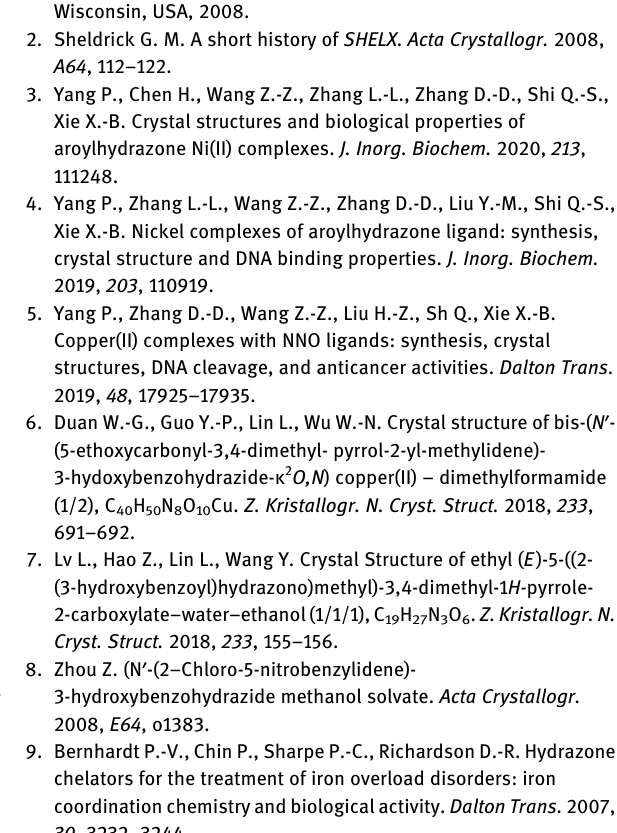
typical C=N doublebond. The C8=N2 – N1 angle is 117.15(13) ° . The two aromatic rings form the dihedral angle of 17.42(1) ° . In the crystal structure, the water molecules are linked to the schiff base molecules through intermolec-